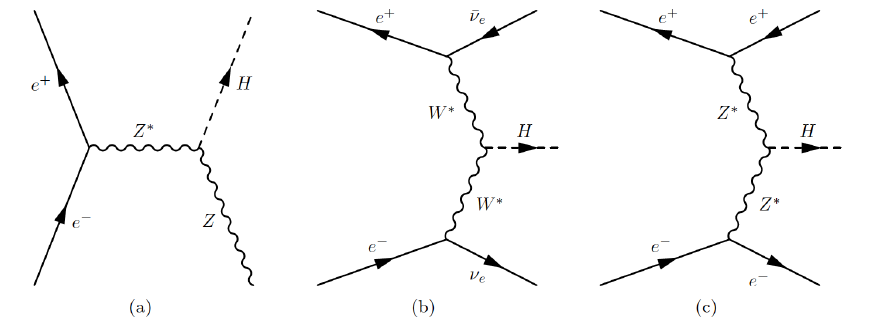
Figure 2 . The Feynman diagrams of the Higgs boson production processes in electron-positron collisions [10], (a) e + e − → ZH , (b) e + e − → ν